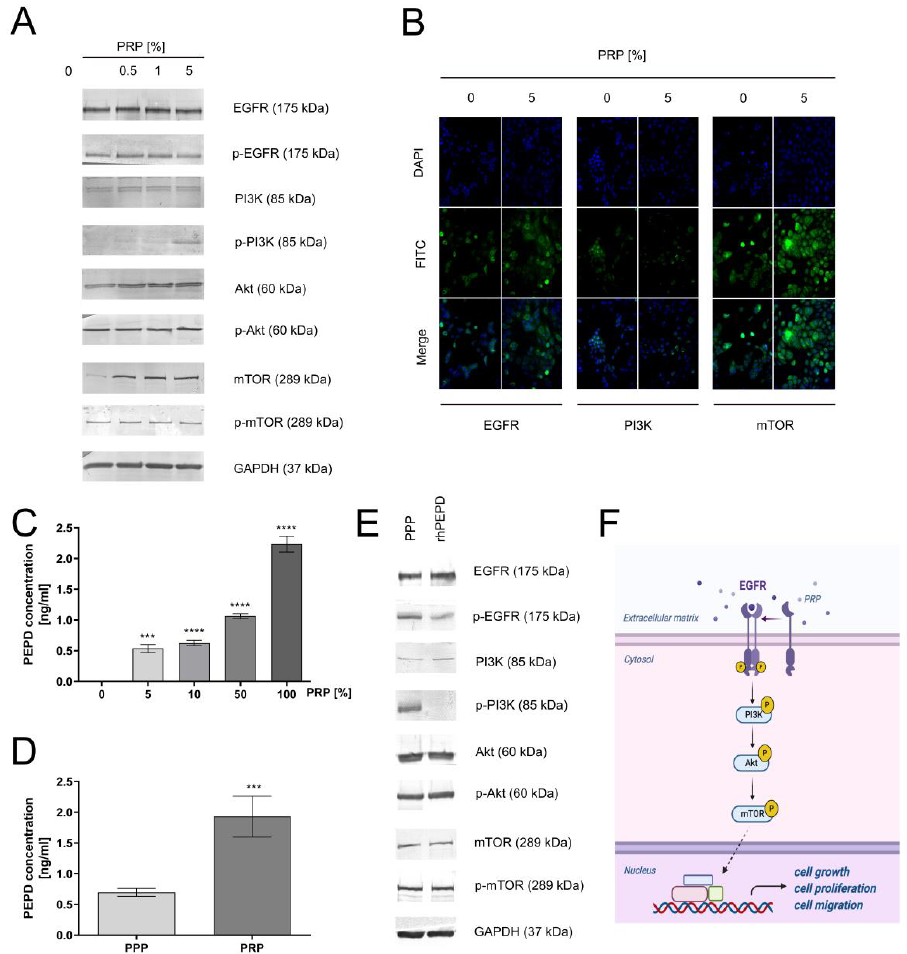
Figure 3. PRP-dependent activation of epidermal growth factor receptor (EGFR) and its downstream signaling proteins in HaCaT cells ( A ) PRP-mediated EGFR-downstream signaling; ( B ) Immunocytochemical staining of EGFR, PI3K and mTOR in keratinocytes treated with 5% PRP. Magnification 200 × ; ( C ) Prolidase (PEPD) concentration in different PRP-diluted samples measured by the ELISA kit; ( D ) PEPD concentration in platelet-poor plasma (PPP) and platelet-rich plasma measured by ELISA kit. Statistical significances were expressed using asterisks such as *** <0.001 and **** <0.0001; ( E ) Western immunoblotting of EGFR-downstream signaling in recombinant human prolidase (rhPEPD- and PPP-treated keratinocytes; ( F ) An illustration of PRP-mediated EGFR-downstream signaling. Created with